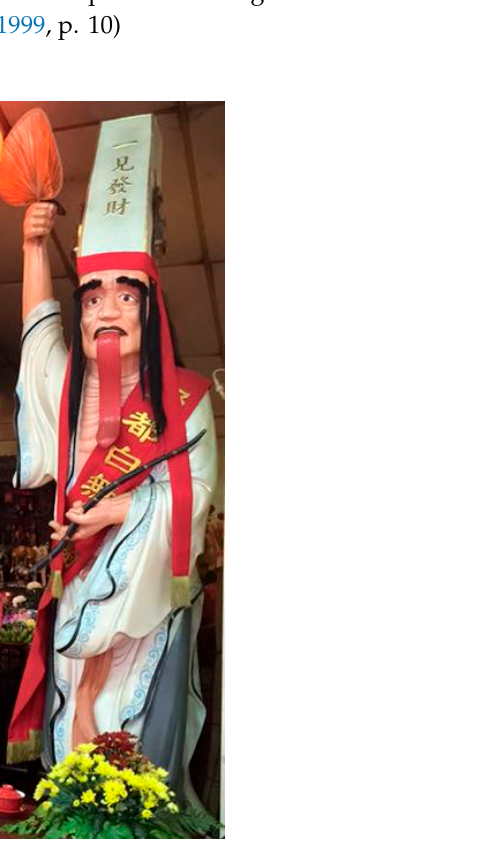
Figure 7. Statue of the White Impermanence Ghost in a local temple (Source: Author).